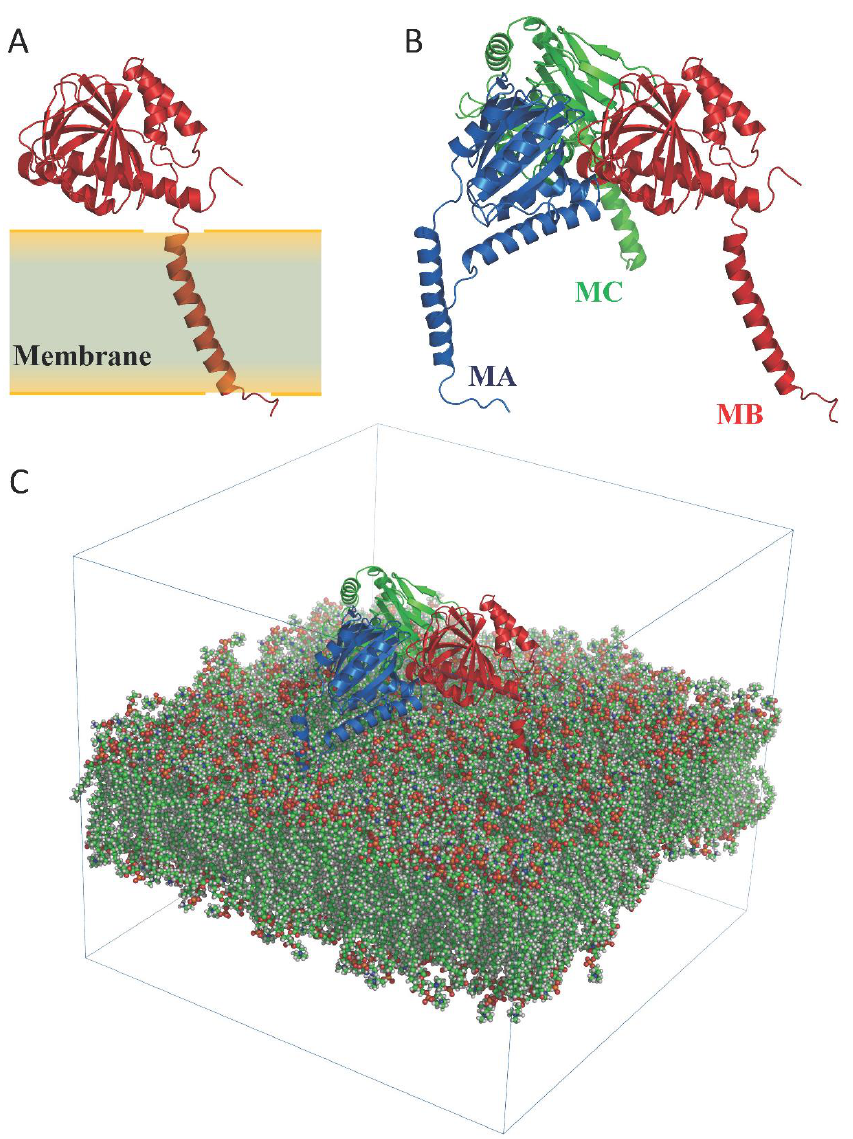
Figure 1. Structure of Hs σ1 -R protein. ( A ) A single monomer is shown as ribbon. The position of the monomer with respect to the membrane region of the protein is highlighted. ( B ) The homotrimer is shown as ribbon. The three monomers (MA, MB and MC) are colored blue, red and green, respectively. ( C ) Simulated system within the simulation box. Membrane atoms are shown as spheres and colored by atom type: C, O, N, P and H are green, red, blue, orange and white, respectively.